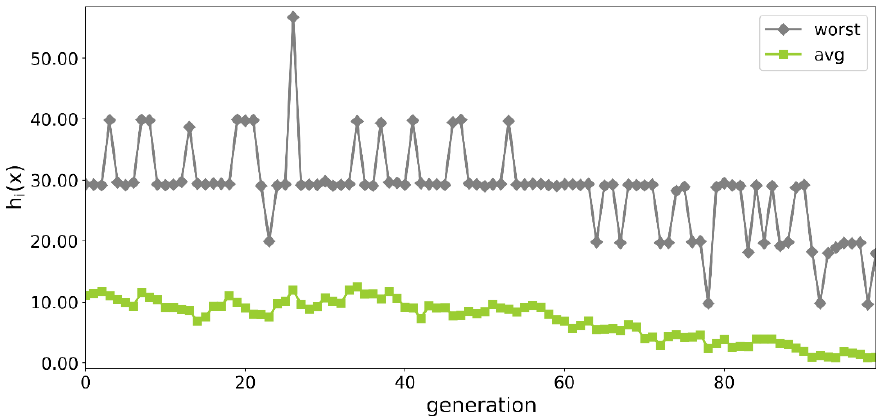
Figure 4. Value of the worst and the average specimen over the generations.